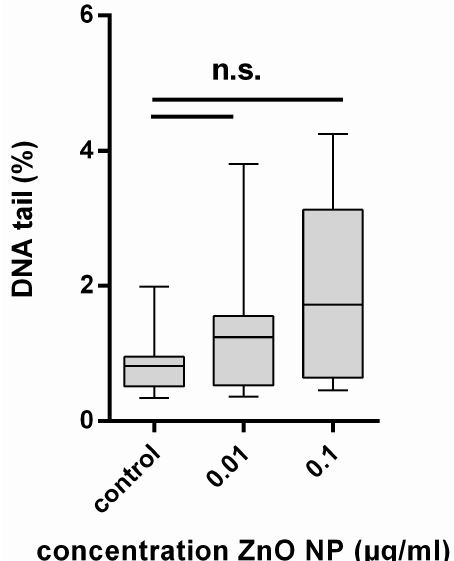
Figure 6. DNA damage expressed by the percentage of DNA in the tail of hMSC after repetitive exposure to ZnO-NP. BEGM served as control, n = 8. For statistical analysis, the Wilcoxon Test was performed. Statistical significance compared to the control based on a p -value < 0.05. No significant increase in DNA damage was observed. n.s.: none signifanct.